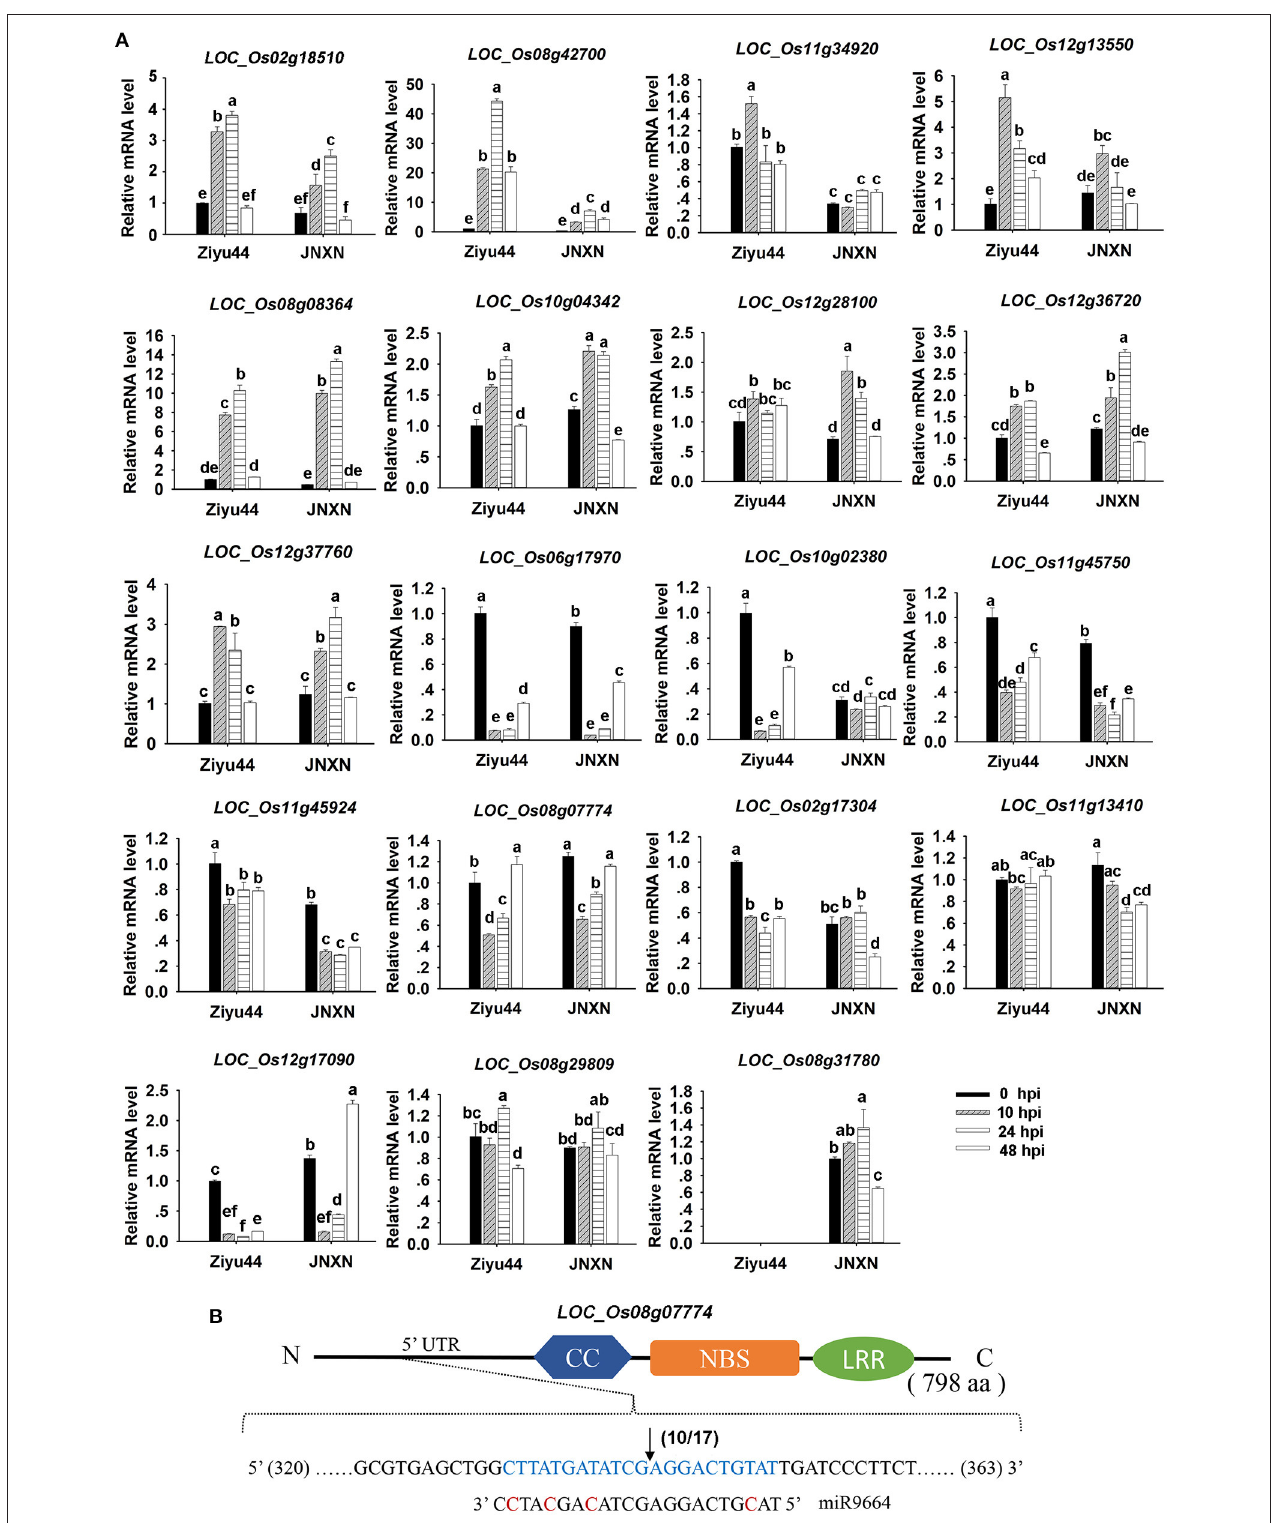
FIGURE 8 | (A) Expression of miR9664 target genes in Ziyu44 and JNXN upon M. oryzae infection. qRT-PCR results were normalized with the Ubi reference gene, the indicated mRNA level is normalized to those in the untreated control plants (0 hpi). Error bars indicate SD ( n = 3), the letters above the bars indicate